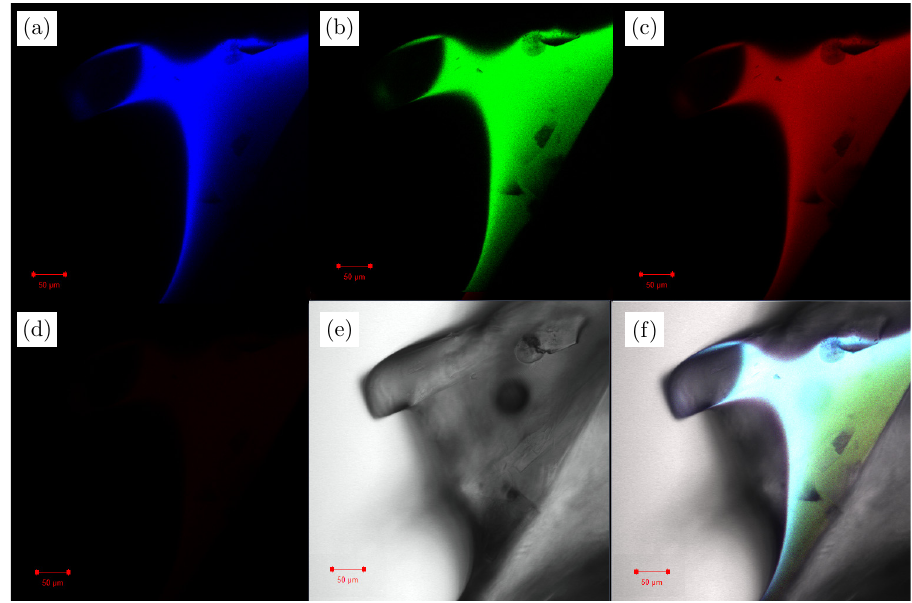
Fig. 3. A piece of lyophilized urine fraction in a confocal microscope (objective magni¯cation 20 (cid:4) ). Excitation wavelengths and bandpass ¯lters used here are: (a) 405 nm (410 – 483 nm) (blue); (b) 488 nm (494 – 571 nm) (green); (c) 561 nm (575 – 712 nm) (red); (d)